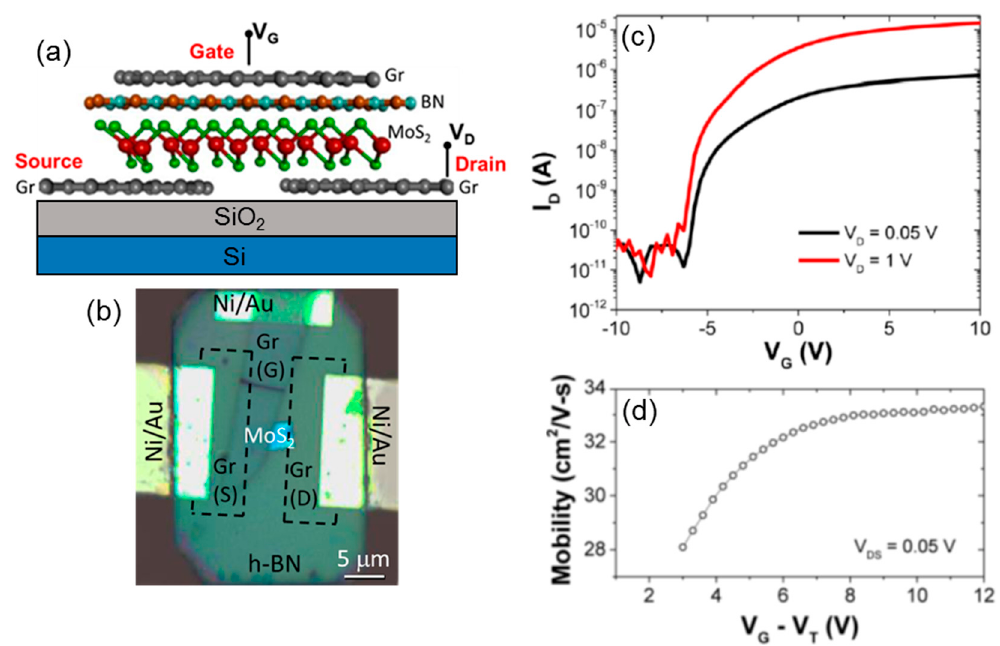
Figure 3. Schematic ( a ) and optical microscopy ( b ) of an FET with all components formed by 2D materials, where MoS 2 works as the channel, hexagonal boron nitride (h-BN) as the dielectric layer for top electrode isolation and Gr for semimetal source/drain contacts. Transfer characteristics ( c ) and mobility vs. gate bias behavior ( d ) of this transistor. Figures adapted with permission from [69]